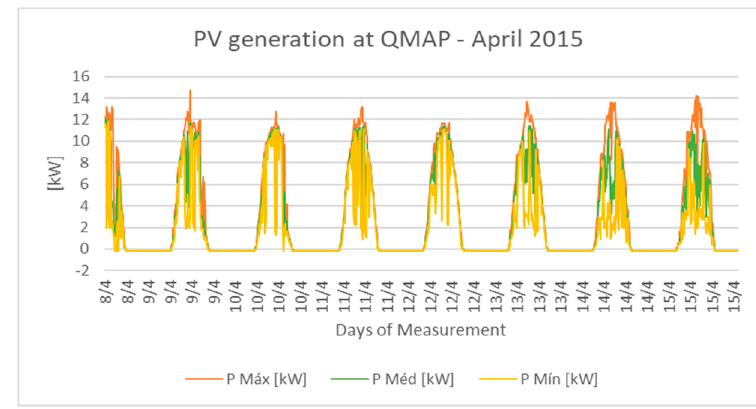
Figure 10. PV generation for one week of measurement.